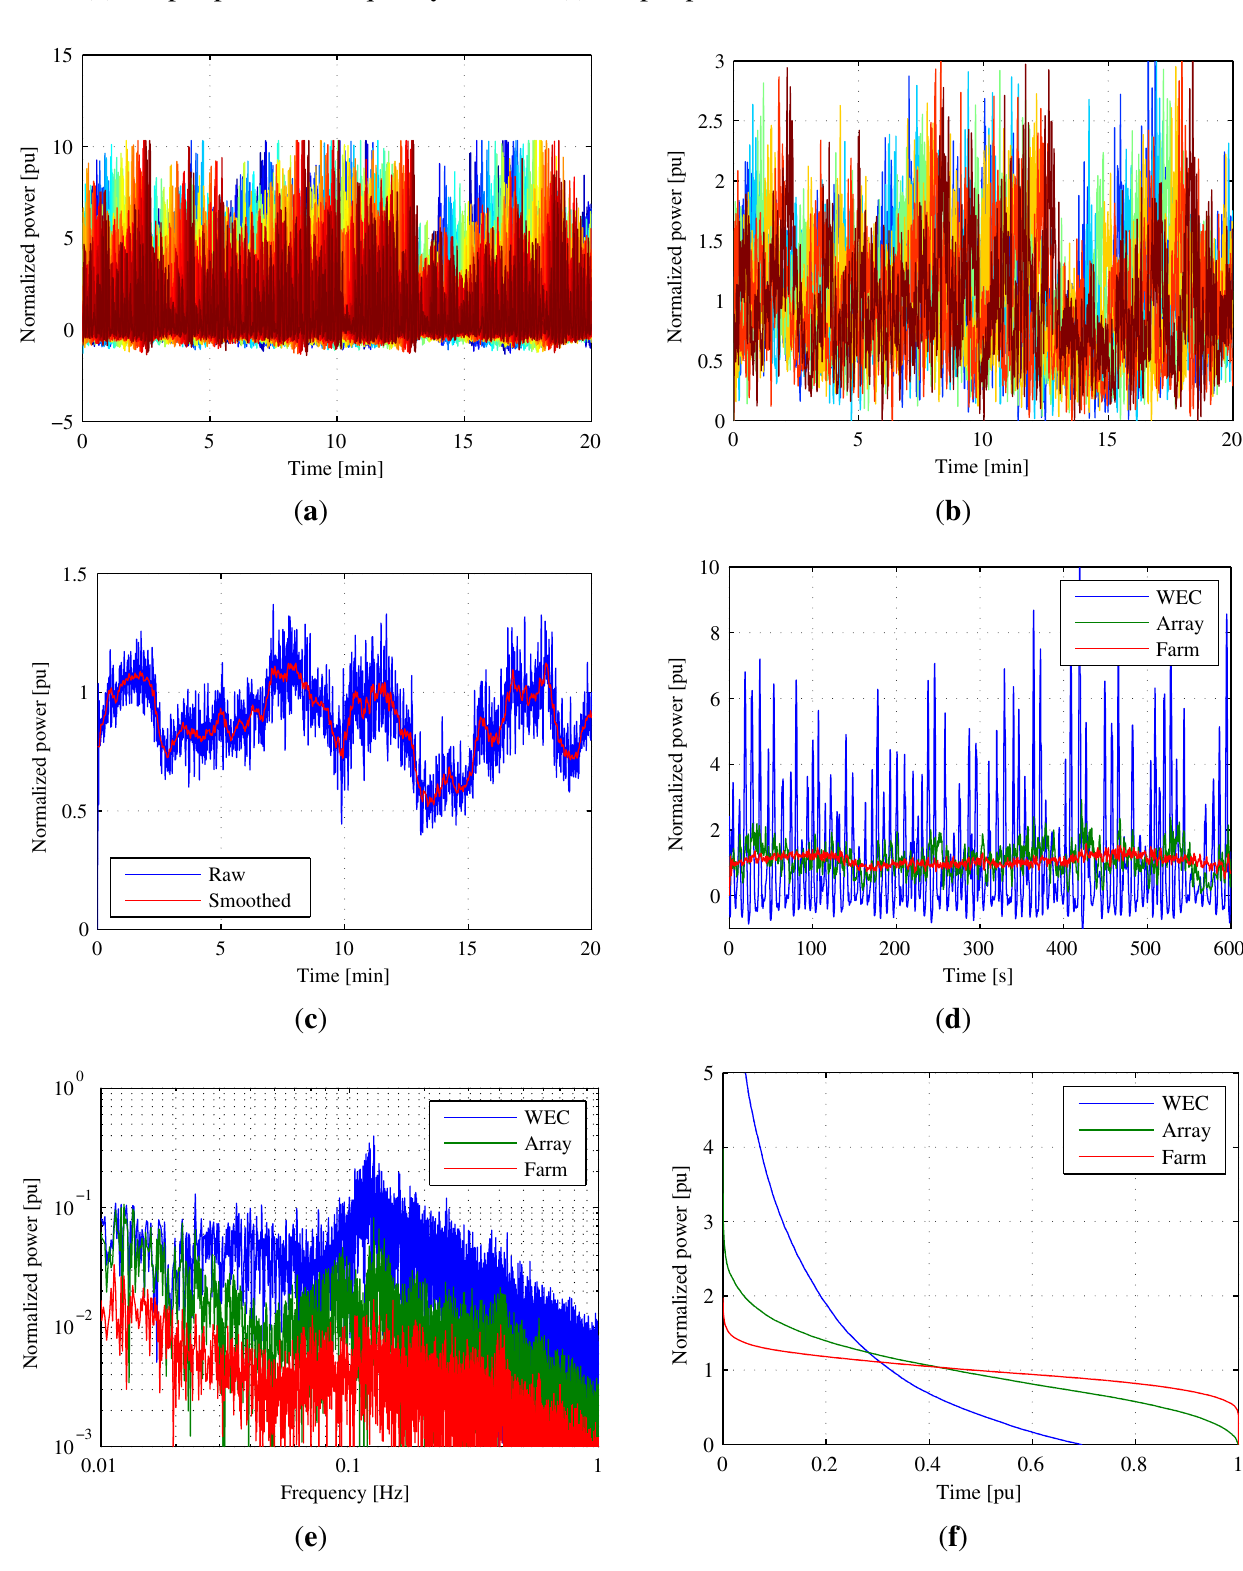
Figure 12. Simulation results. All values are normalized to the average output power of the unit (WEC/array/farm). ( a ) Individual power output from all 48 WECs; ( b ) Aggregated power output from each of the six arrays; ( c ) Aggregated power output from the entire wave farm. The red curve shows the output power smoothed with a 10-second low pass filter; ( d ) Illustration of the power quality improvement as the power is aggregated in the farm; ( e ) Output power in frequency domain; ( f ) Output power